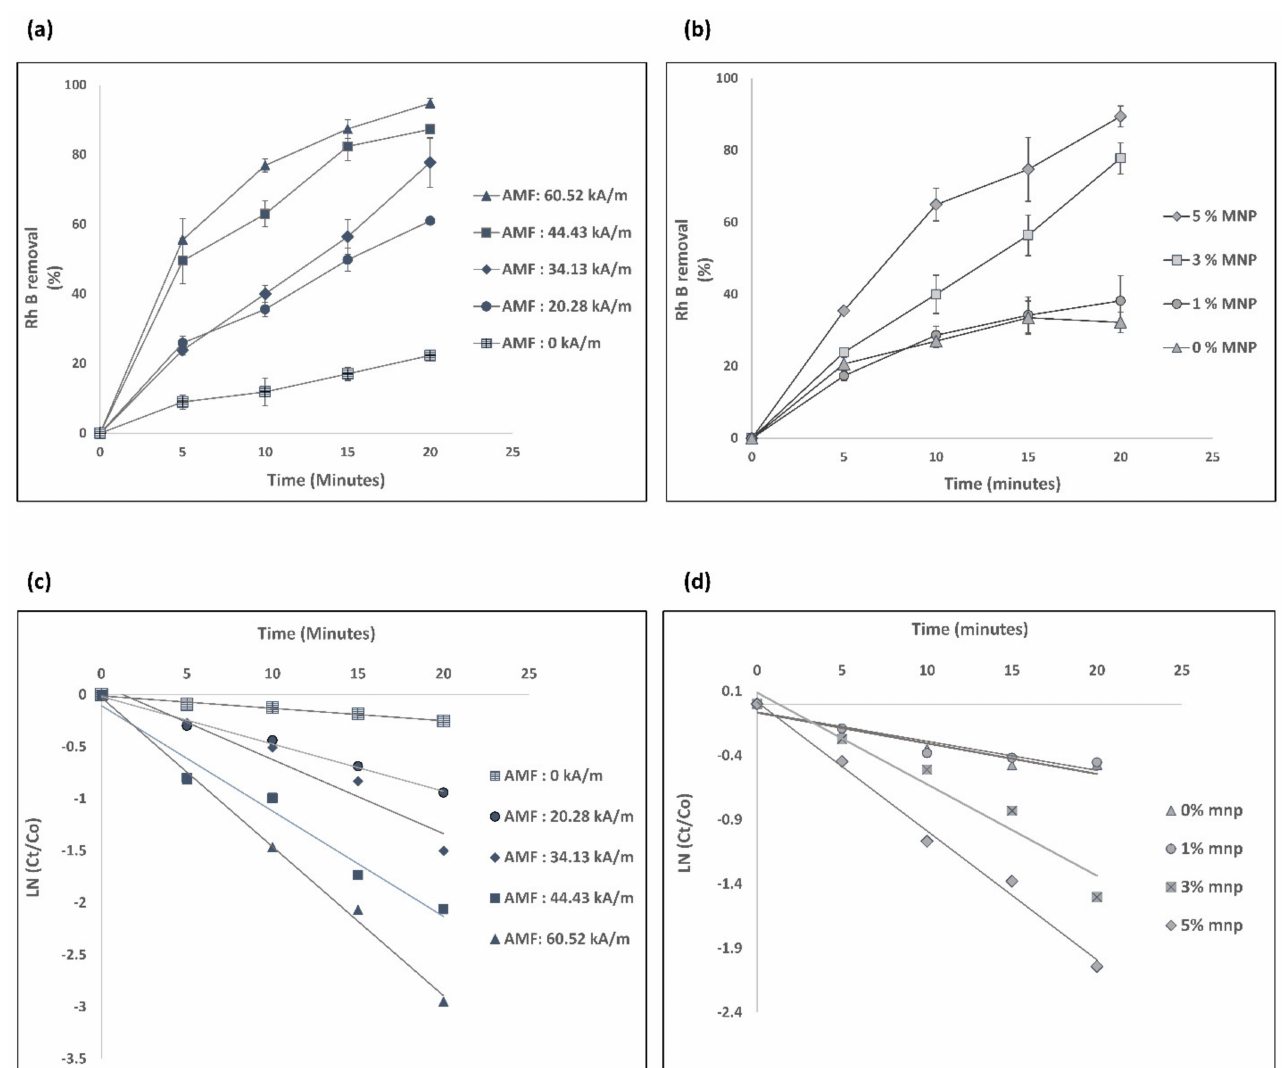
Figure 4. Removal of RhB with SPS ( a ) at different strengths of AMF with a nanocomposite of 3% MNP; ( b ) with different MNP concentrations in nanocomposites with an AMF strength of 34.13 kA/m. Pseudo-first-order plot of the RhB degradation ( c ) at different strengths of AMF with a nanocomposite of 3% MNP; ( d ) at different MNP concentrations in the nanocomposite with an AMF strength of 34.13 kA/m; (N = 3, error bars represent the standard deviation). Table 2. Reaction rate constant of RhB degradation at different MNP concentrations in nanocompos- ites with an AMF strength of 34.13